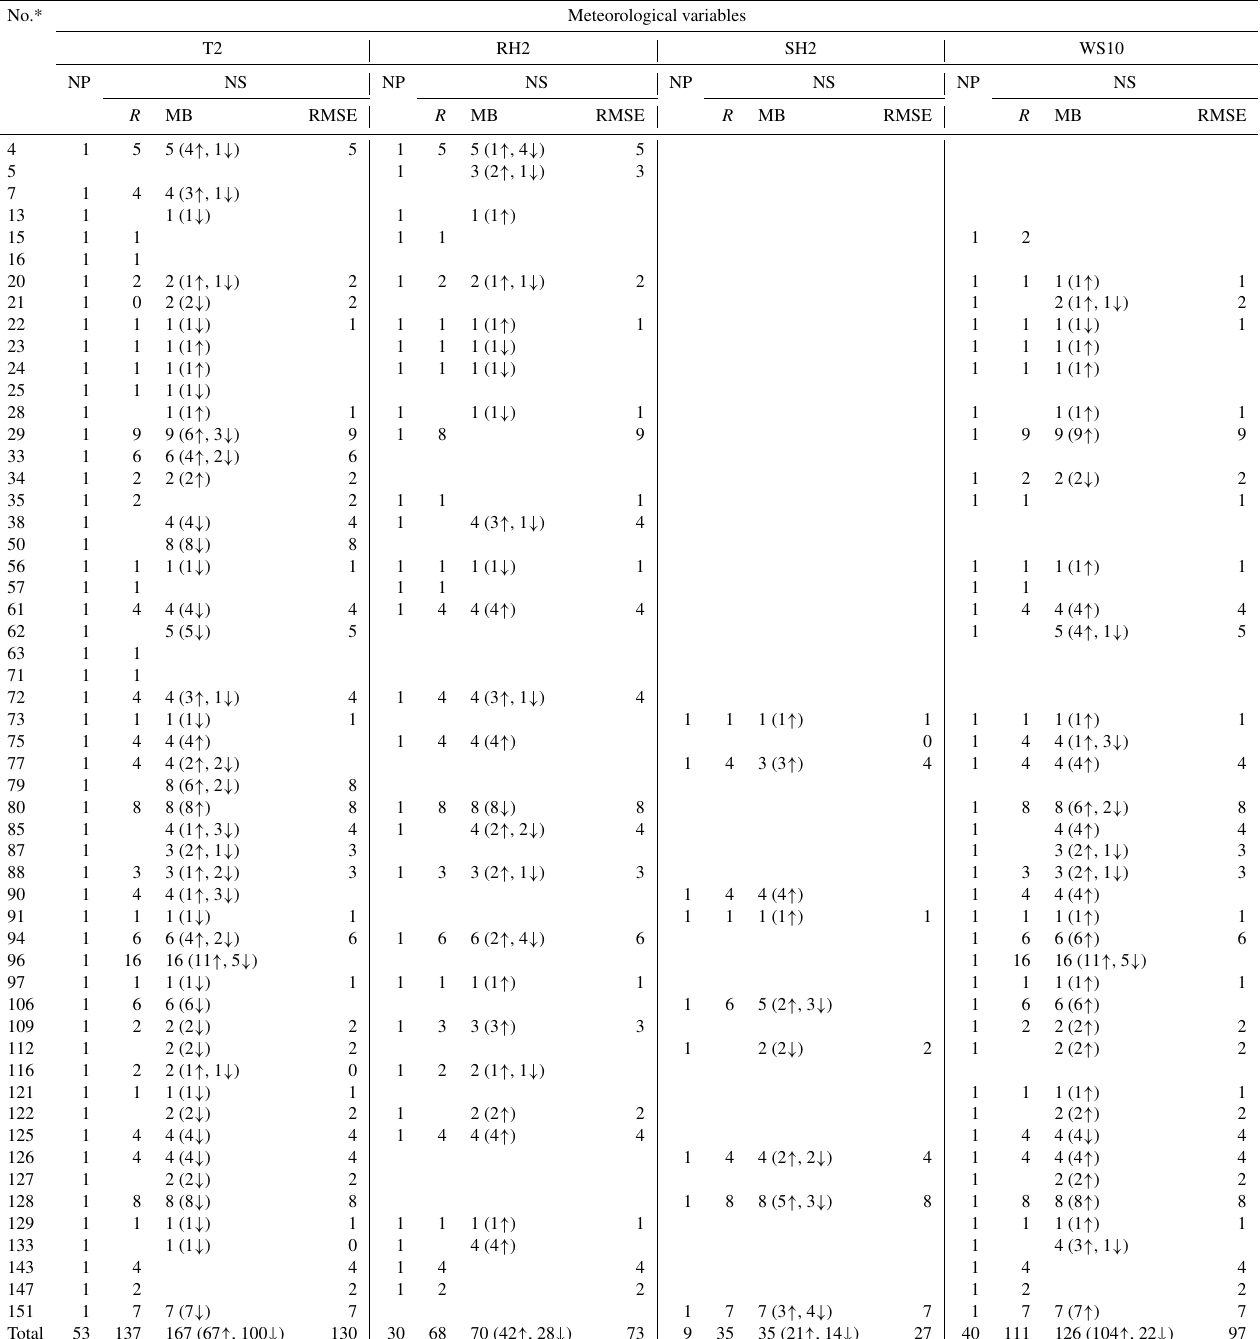
Table B2. The compiled number of publications (NP) and number of samples (NS) for papers providing statistical indices (SIs) of meteoro- logical